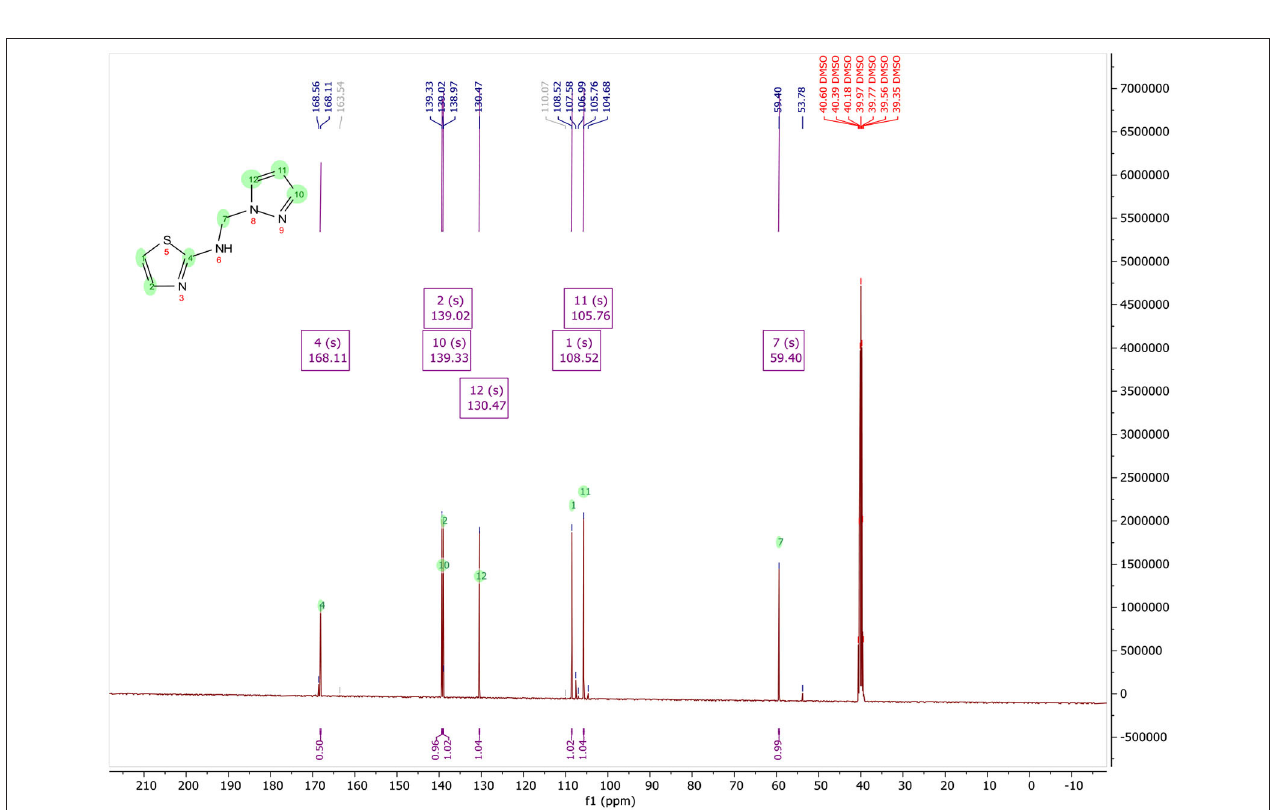
Frontiers in Chemistry |